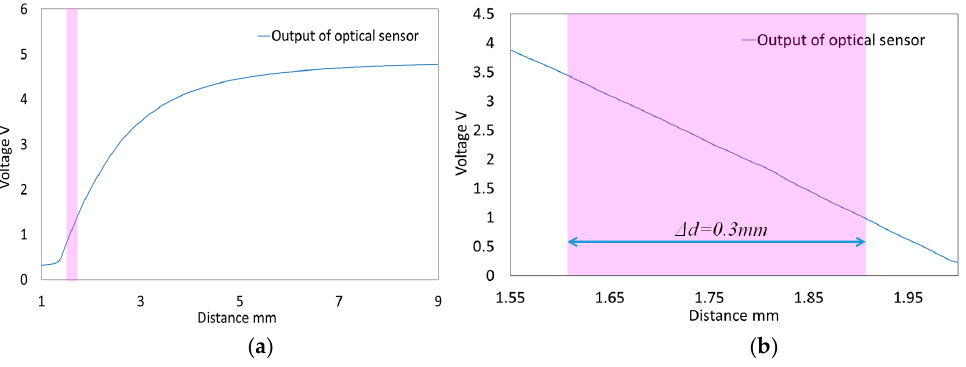
Figure 8. Characteristic curve of output voltage of optoelectronic sensor according to changing d: ( a ) Without amplifier; ( b ) With amplifier.